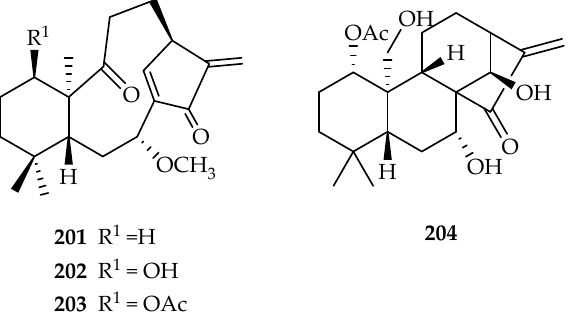
Figure 81. Structures of kongeniods A–C 201 – 203 [127] and compound 204 [128]. The novel compound 1 α -acetoxy-7 α , 14 β , 20 α -trihydroxy- ent -kaur-16- en-15-one 204 was isolated from the aerial parts of Isodon excisoides (Lamiaceae) using an orientational preparation method based on a UPLC-LTQ-Orbitrap-MS [128] (Figure 81). Its cytotoxic effect was tested against the HCT-116, HepG2, BGC-823 ( human gastric cancer ), NCI- H1650 (human lung adenocarcinoma bronchioalveolar carcinoma), and A2780 cell lines, and it showed cytotoxic activity, with IC 50 values of 1.34, 1.07, 3.60, 2.35, and 2.53 µ M, respectively, using cisplatin as the positive control.